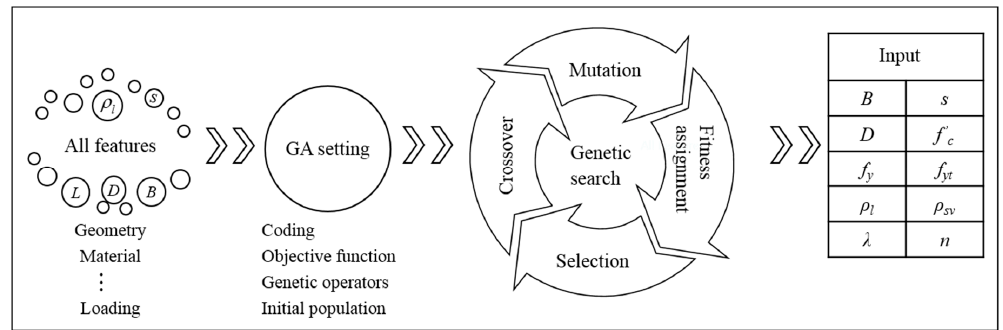
Figure 4. Genetic algorithm for optimal feature selection.